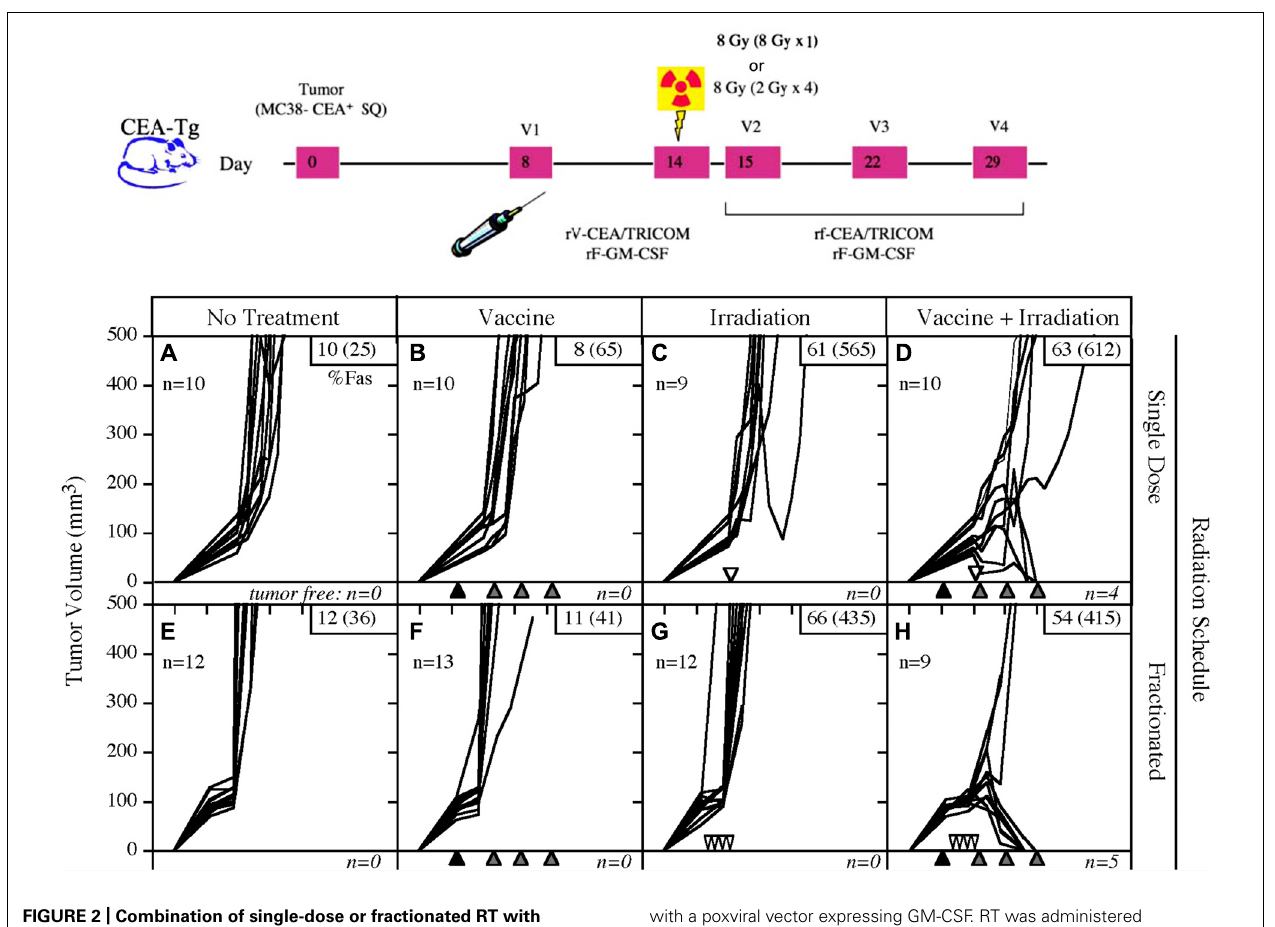
FIGURE 2 | Combination of single-dose or fractionated RT with vaccine therapy. Mice transgenic for CEA were implanted subcutaneously on day 0 with the MC38-CEA tumor cell line, then randomized to receive either no treatment, vaccine alone, EBRT alone, or the combination of vaccine and EBRT.The vaccine consisted of poxviral vectors expressing CEA andTRICOM (rF/V-CEA/TRICOM). All vaccines were coadministered